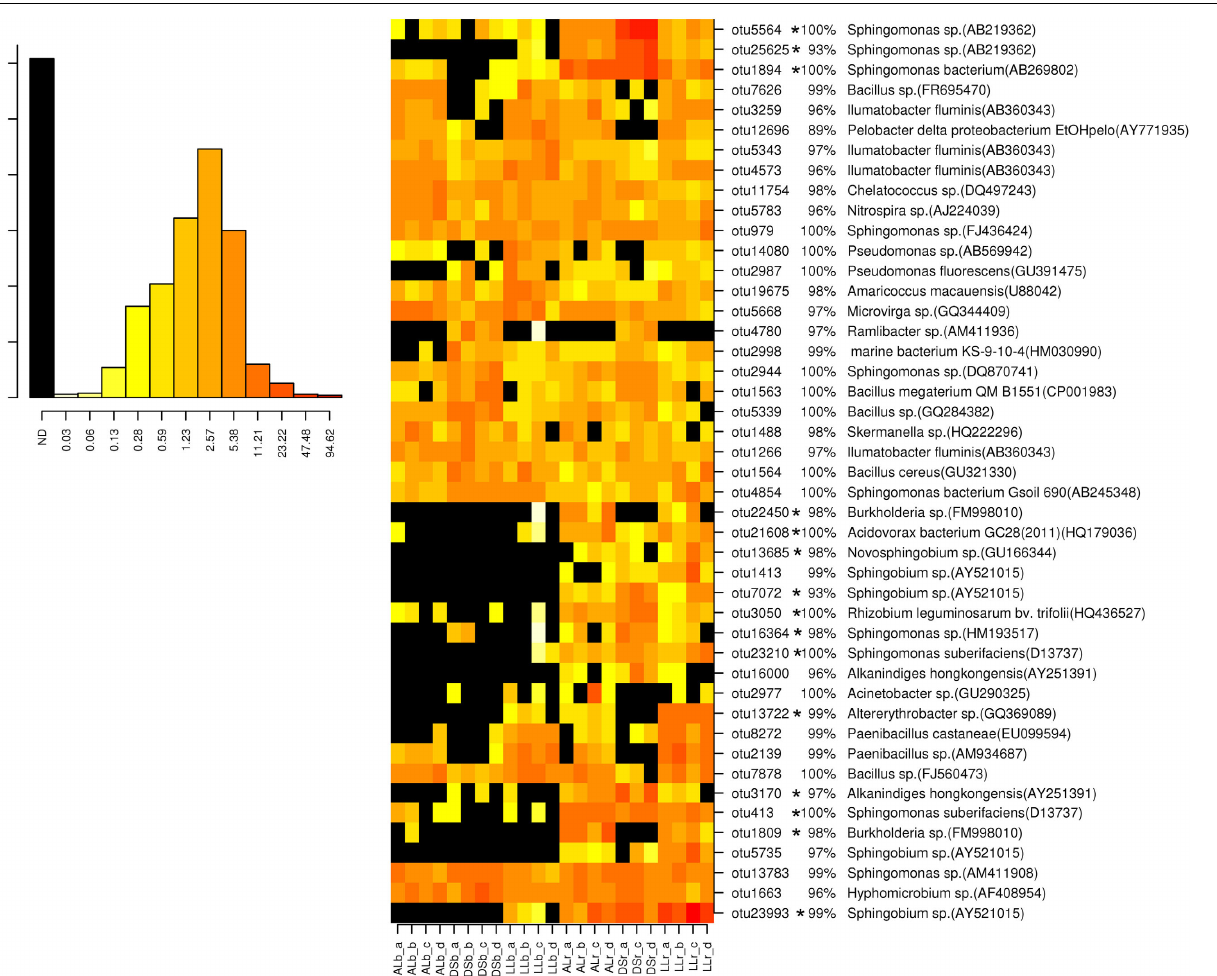
FIGURE 4 | Relative abundance of the most dominant OTUs detected 7 weeks after planting. The heatmap indicates differences in the relative abundances of OTUs in the bulk soil and rhizosphere from lettuce, and between soil types DS, AL, and LL. The vertical columns represent one sample, horizontal rows depict OTU. The color code grades from black (not detected) over yellow (low abundance), orange (medium abundance) to red (high abundance). Numbers in brackets